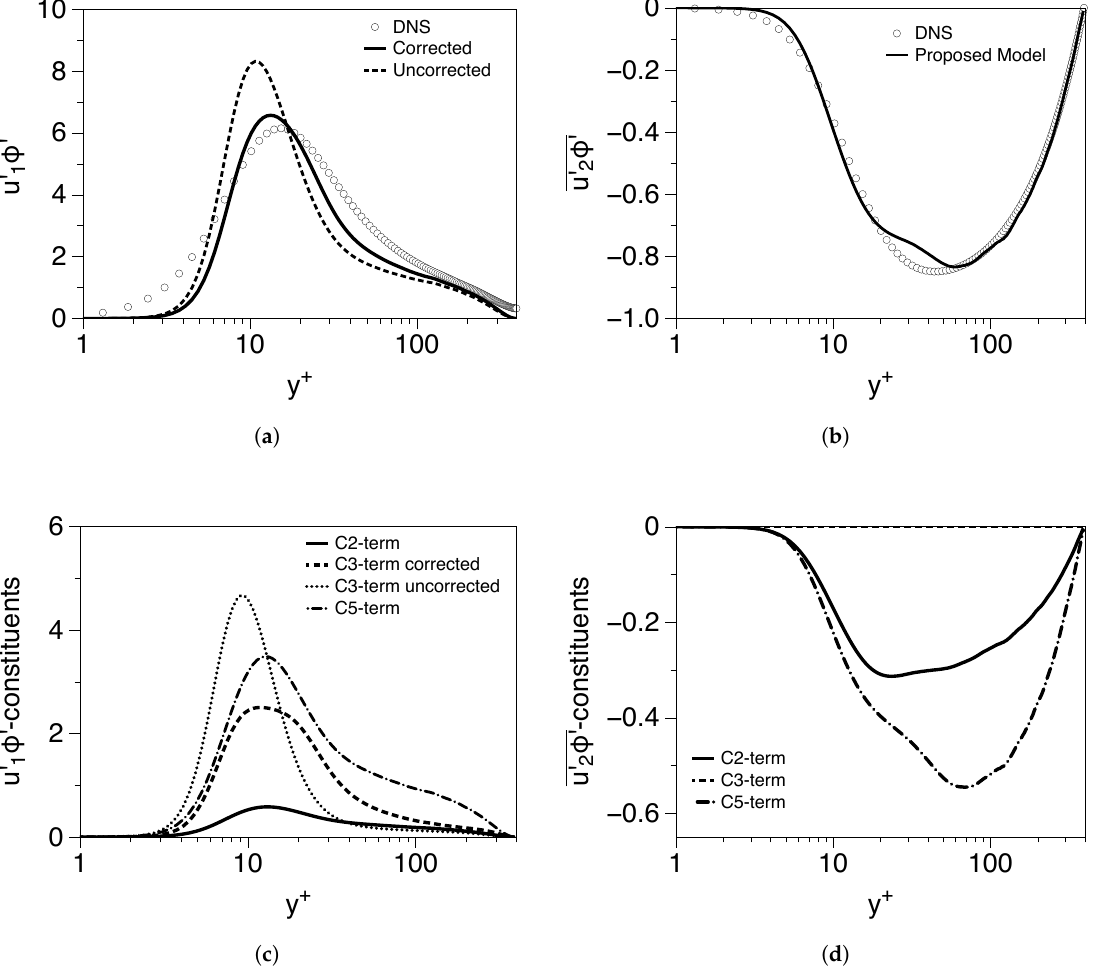
Figure 1. Top: Predictions of the proposed model for the ( a ) streamwise and ( b ) normal scalar-flux components as a function of the distance from the wall y + . Symbols denote the DNS results of [29] for channel flow at Re τ = 395 and Pr = 0.71. Bottom: Balance between the individual terms appearing in the model Equation (15) for the ( c ) streamwise and ( d ) wall-normal scalar-flux